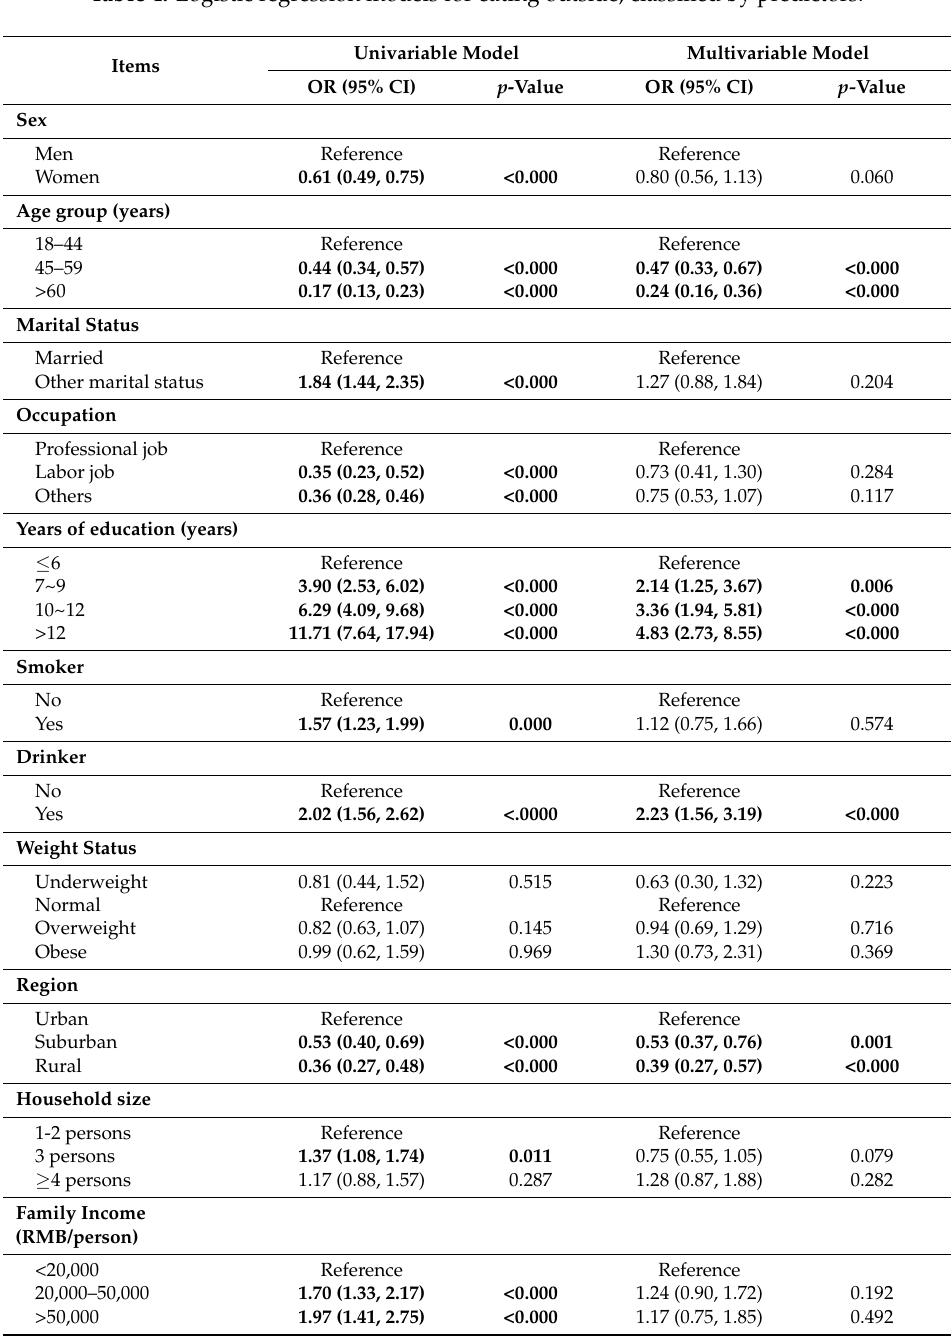
Table 4. Logistic regression models for eating outside, classified by